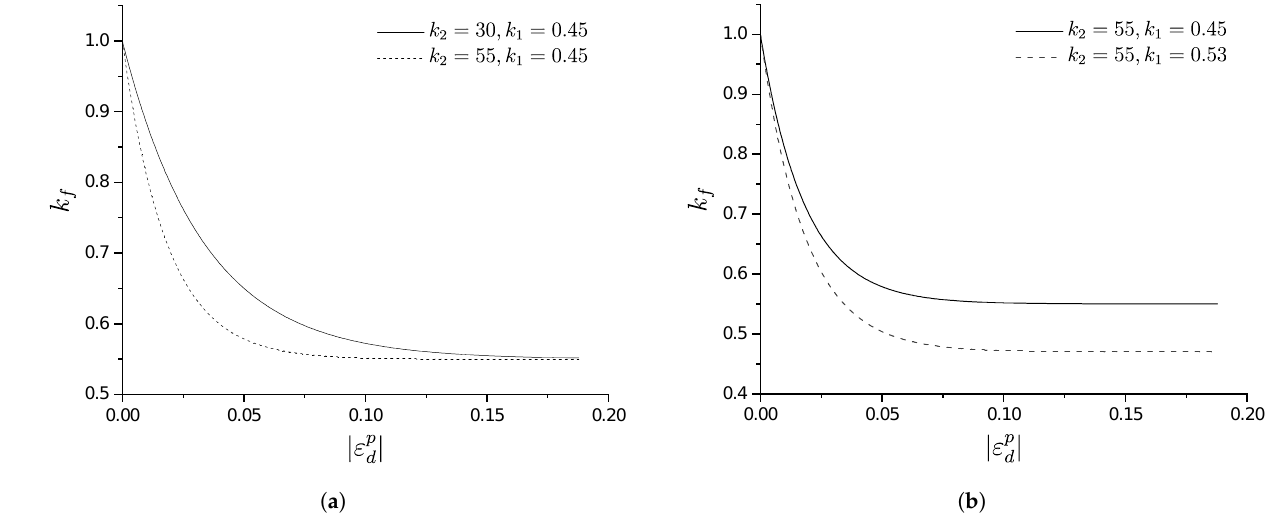
Figure 4. Influence of k 1 , k 2 on k f . ( a ) Influence of k 2 on k f , ( b ) Influence of k 1 on k f